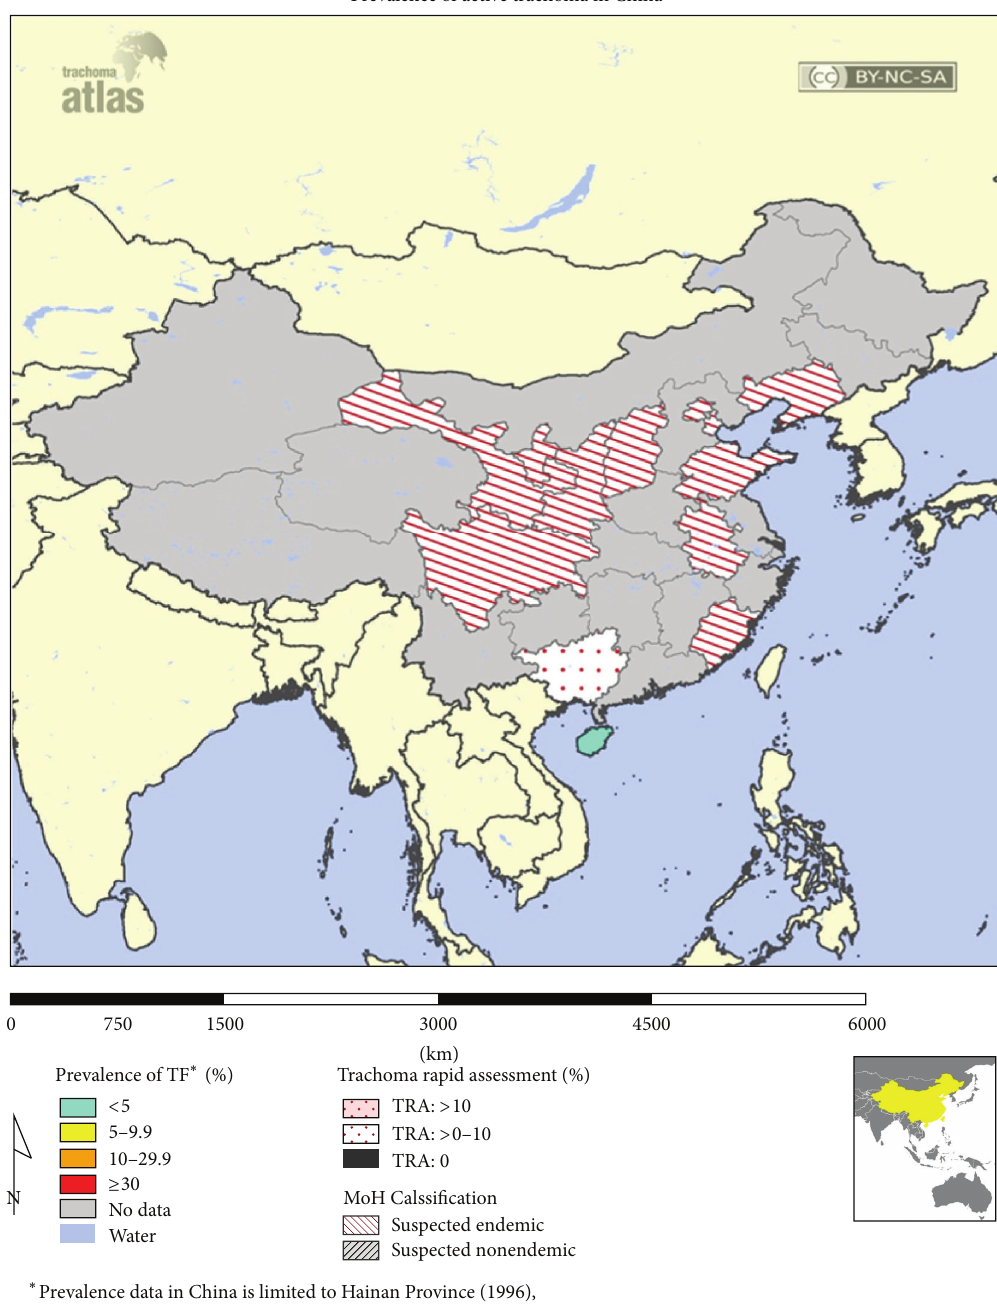
Figure 4: Prevalence of trachoma in China using trachoma follicular as clinical indicator. Figure courtesy of Trachoma Atlas [7].